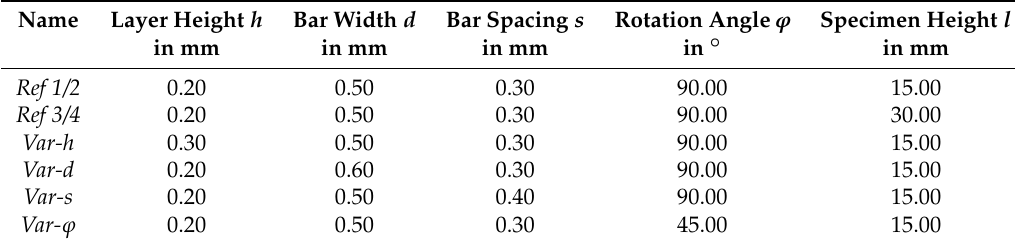
Table 1. Overview of the investigated